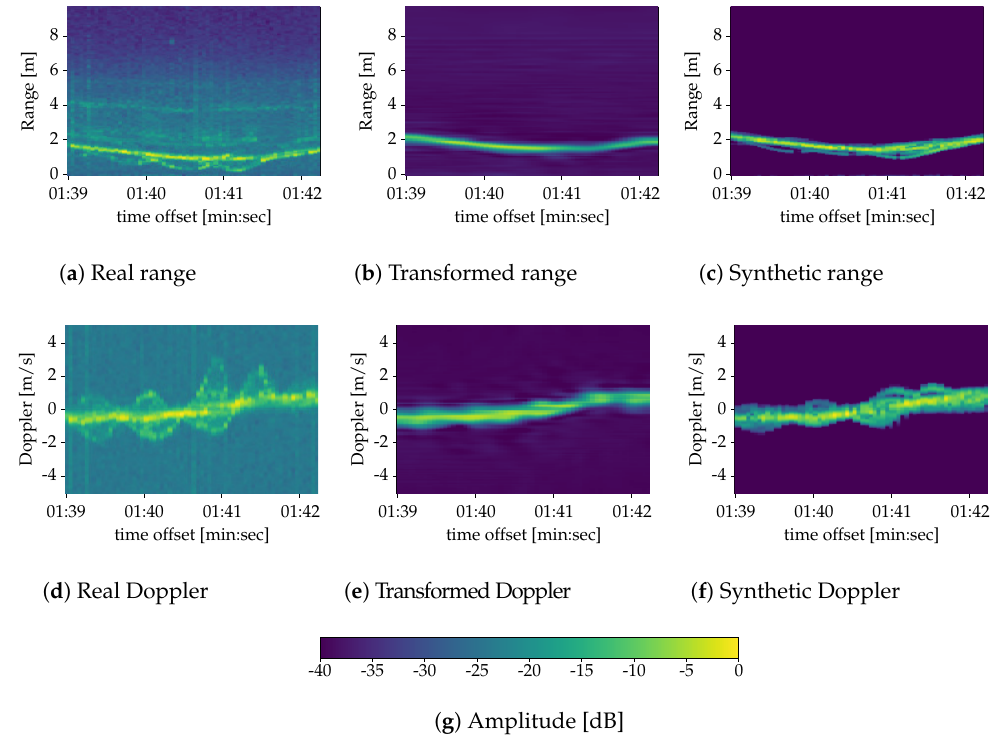
Figure 8. Comparison of range ( a – c ) and Doppler ( d – f ) spectrograms for real ( a , d ), transformed ( b , e ) and synthetic ( c , f ) data. The spectrograms display an instance of the activity item (e) in Section 2 Boxing and